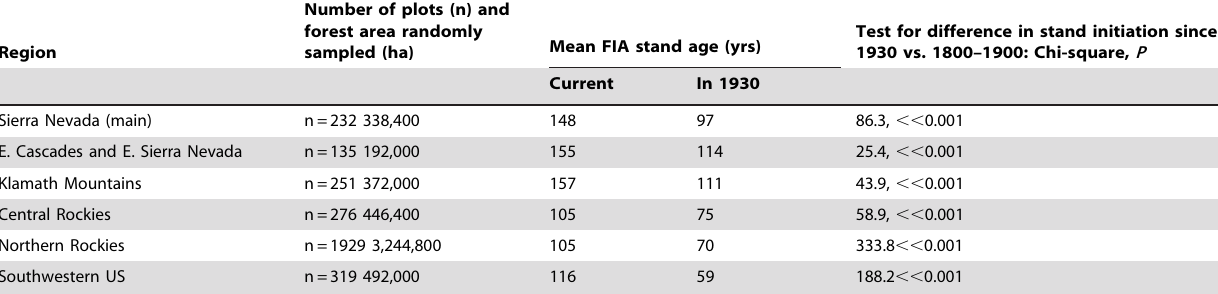
Number of plots (n) and forest area randomly